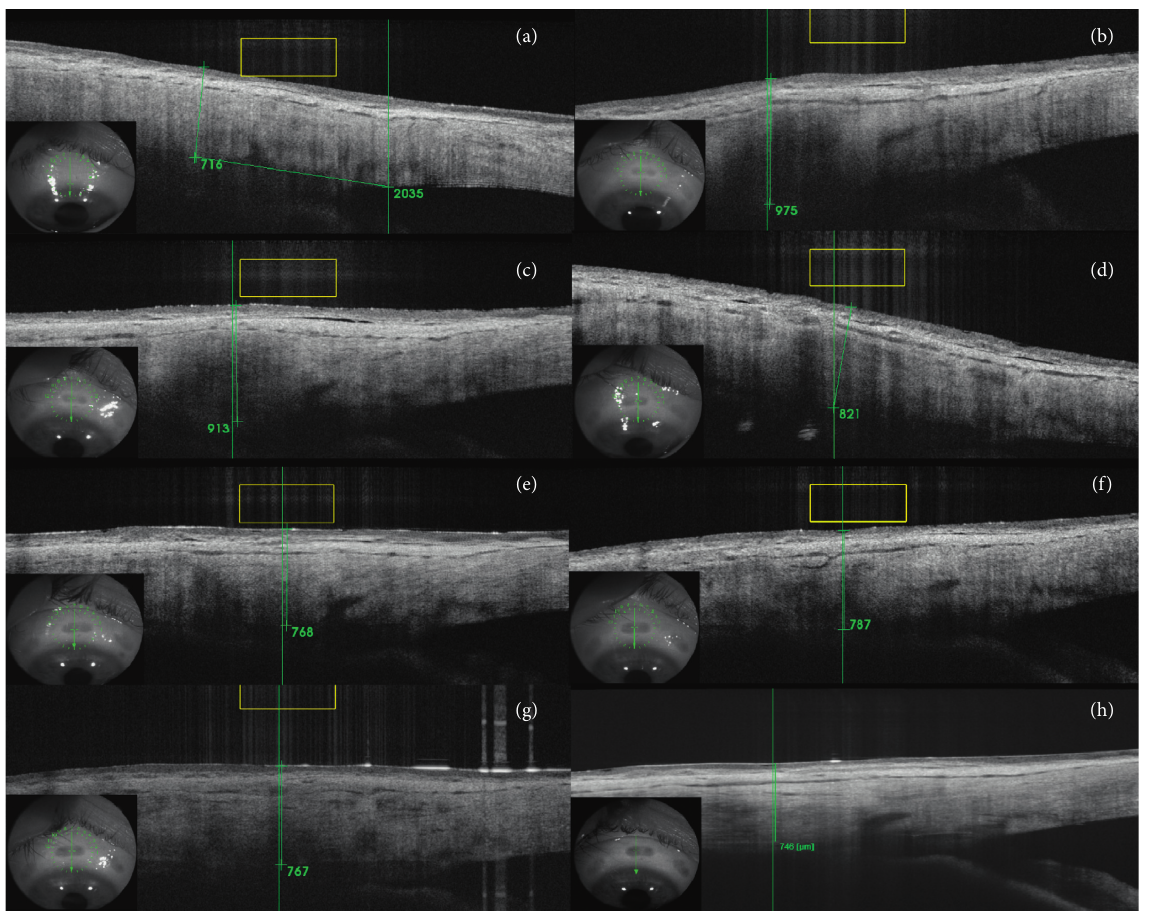
Figure 7: Superior-quadrant OCTscans of the sclera and conjunctiva of a patient before the procedure (a), at 1 week (b), and 1 (c), 3 (d), 6 (e), 12 (f), 18 (g), and 24 (h) months after UCP—24-month follow-up